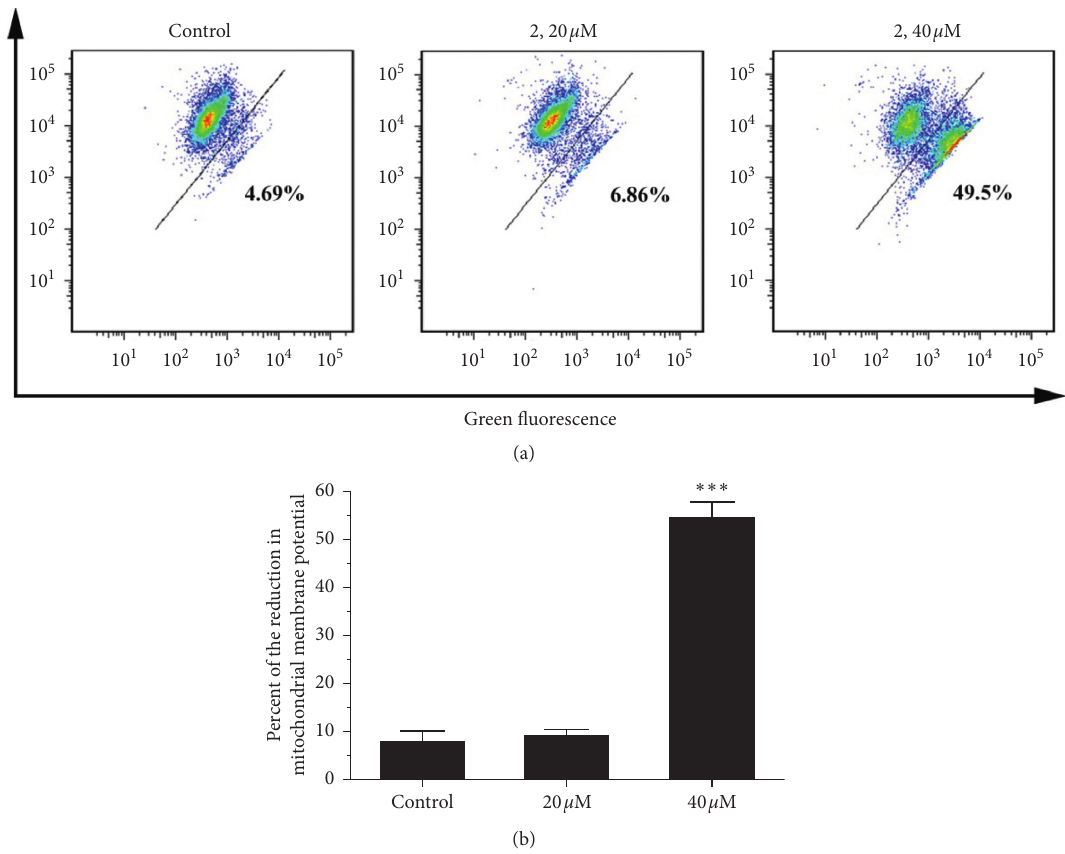
Figure 6: (a) Eca-109 cells’ mitochondrial membrane potential was detected by JC-1 staining assay after coincubation with different concentrations (0, 20, and 40 μ M) of complex 2 for 24 h. (b) Quantitative data analysis for the number of cells (% of total) in the reduction of mitochondrial membrane potential for different treatment groups. Data were presented as mean ± SD ( n � 3), Student’s t -test, ∗∗ P < 0 .